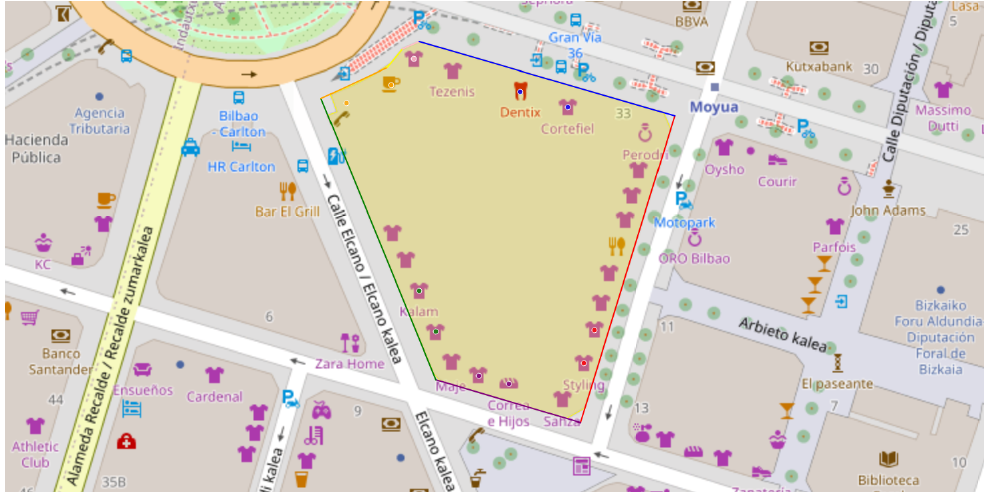
Figure 19. The nearest neighboring nodes per